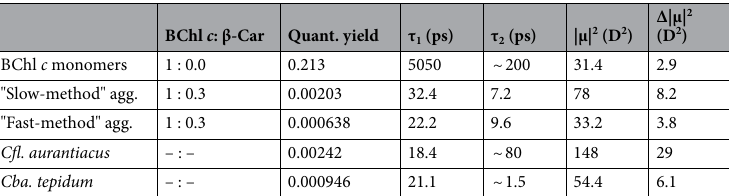
(cid:31) 3 φ fl | µ | 2 = 3 ε 0 h air 16 π 3 τ fl ) and their standard n